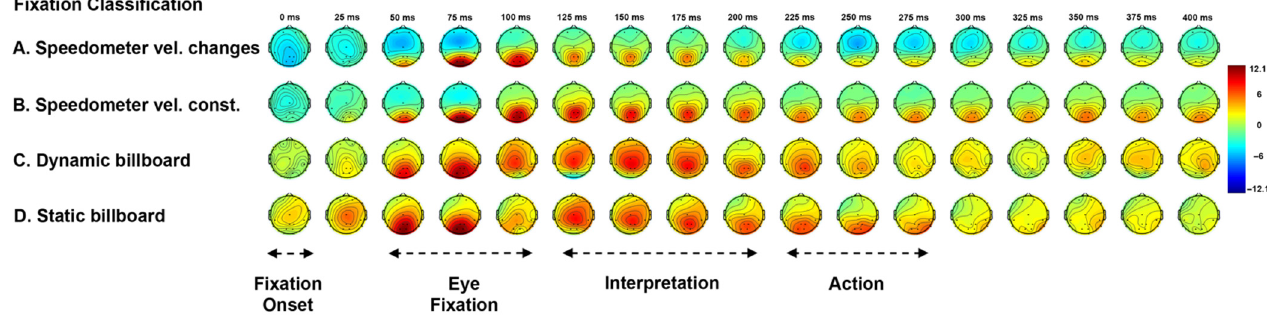
Figure 7. Grand average ERP in 2D topographical plot. (Condition A) Grand average ERP with stimulus event of driver fixation onset at the speedometer follow by speed changing. (Condition B) Grand average ERP with stimulus event of driver fixation onset at the speedometer without speed changing. (Condition C) Grand average ERP with stimulus event of driver first fixation on each dynamic billboard after changing the content. (Condition D) Grand average ERP with stimulus event of driver last fixation on each static billboard.